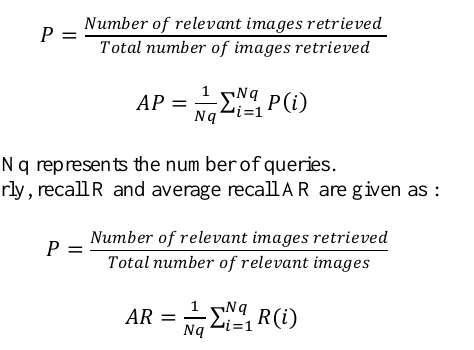
Figure 7. Retrieved image indexed by corresponding colour employing pre-analysis stage.